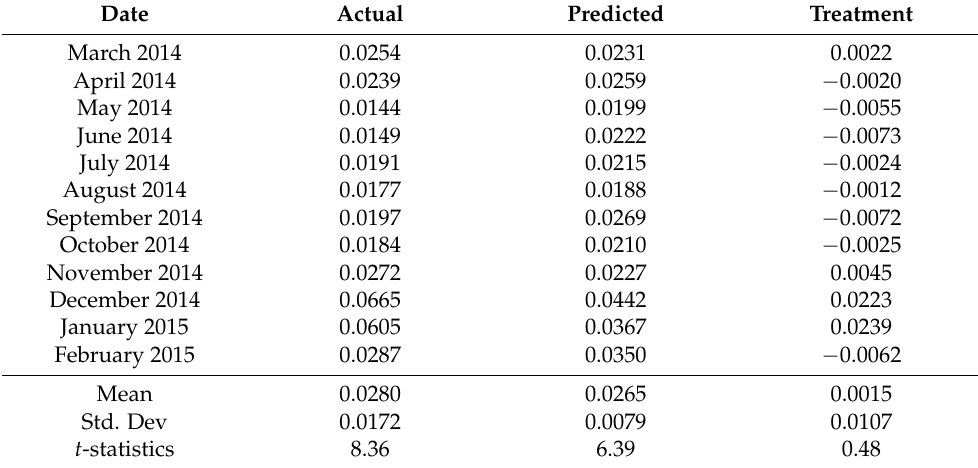
Table 6. Falsification